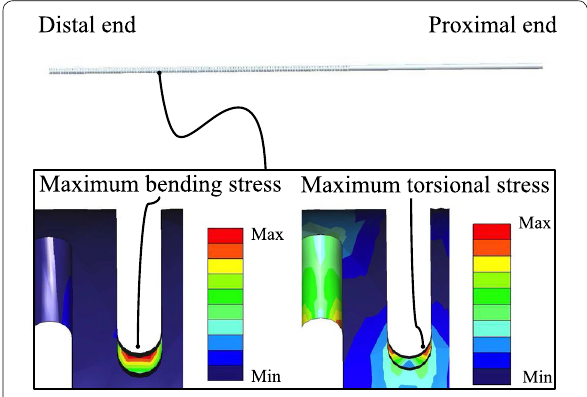
Fig. 11 Developed forceps with the 3.5 mm inner